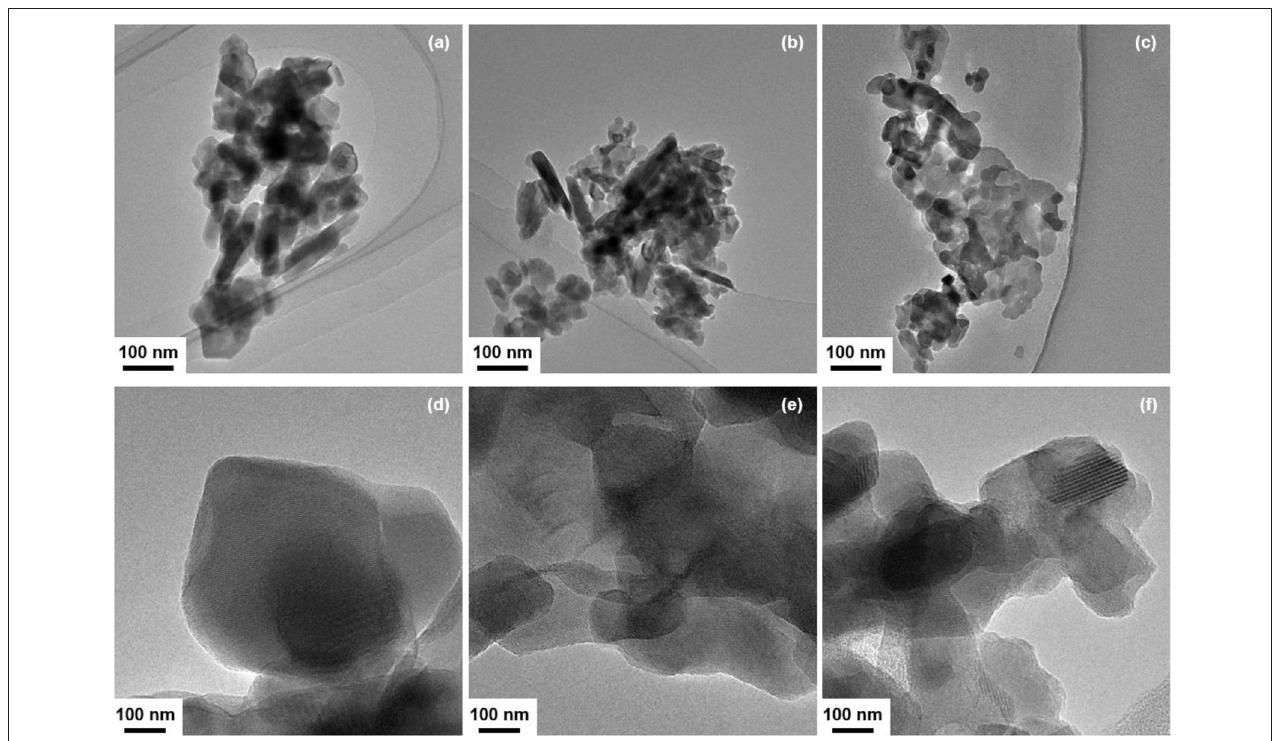
FIGURE 4 | TEM images of (a,d) Y 2 O 3 , (b,e) CeO 2 ( 3 )/Y 2 O 3 (CP), (c,f) CeO 2 ( 10 )/Y 2 O 3 (CP).